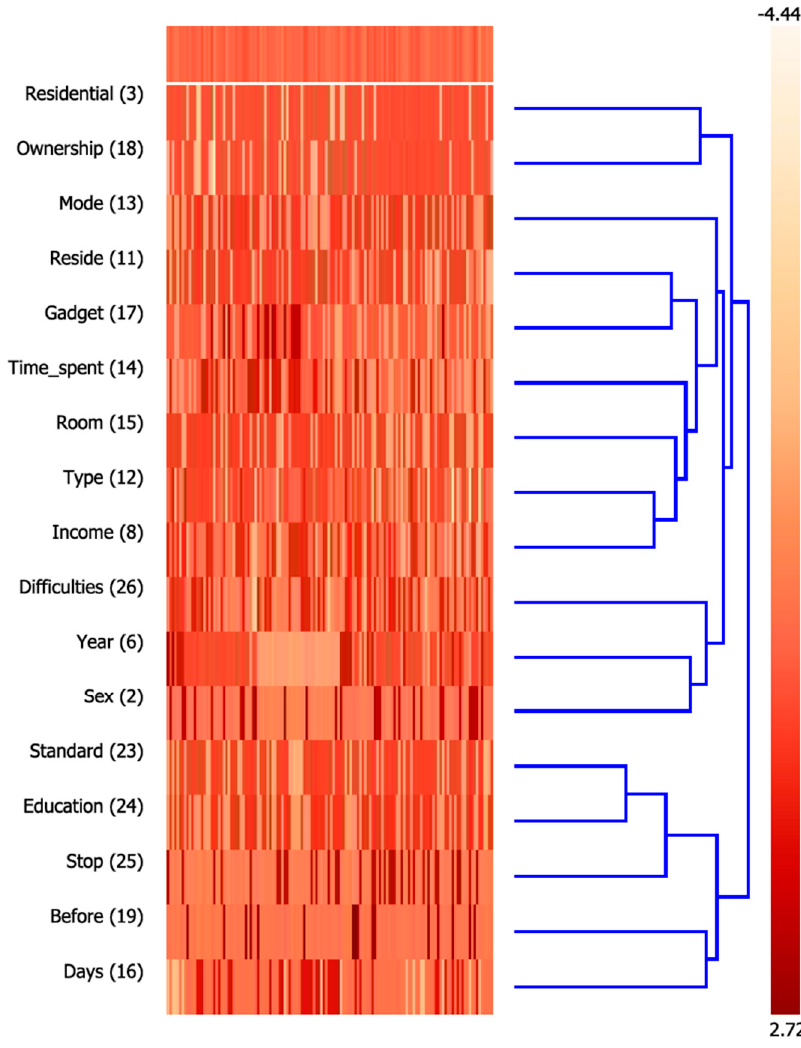
Figure 4. Hierarchical group heat map by variables (right). Table 10. Models’ evaluation of training and validation sets by classification methods.